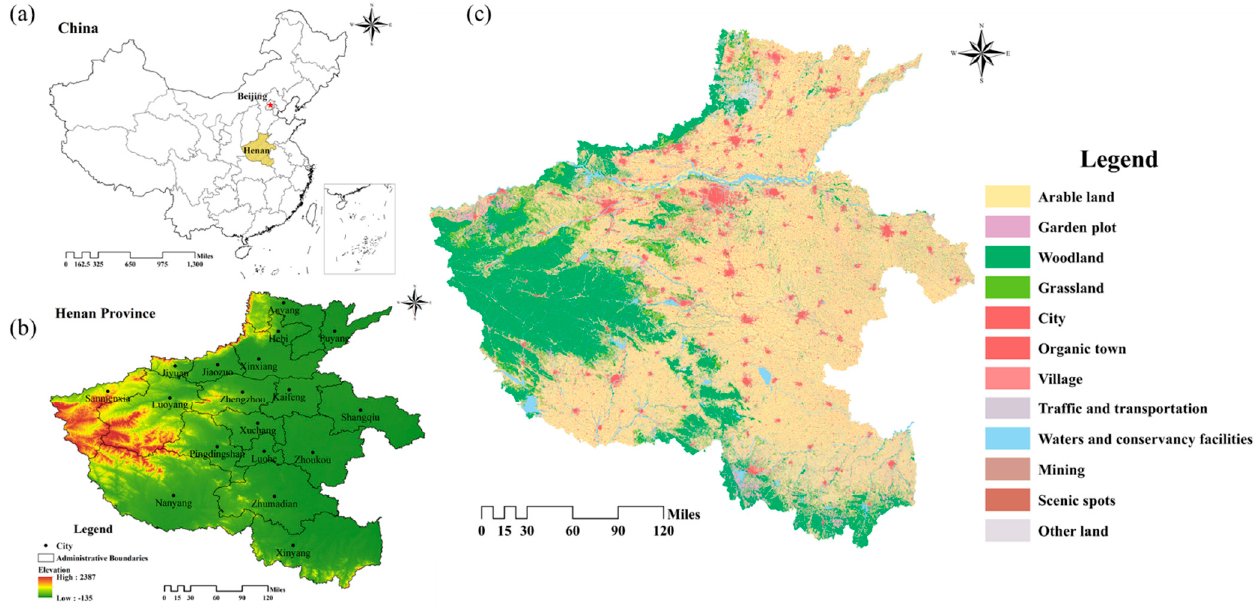
Figure 2. Study area overview: ( a ) the location of Henan province in China, ( b ) elevation of Henan province, and ( c ) land use of Henan province in 2018.